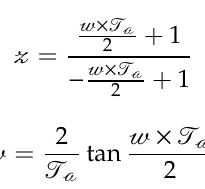
Figure 8. Minimum demand voltage.